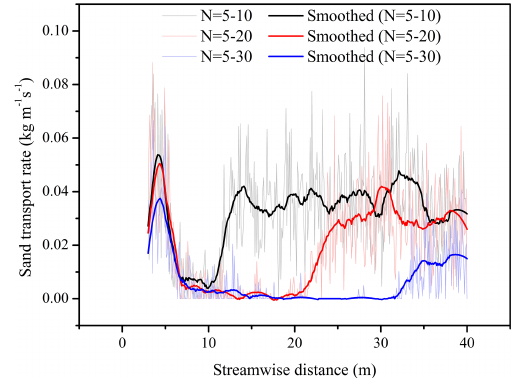
Figure 12. The streamwise sand transport rate in the different lay- ing length cases ( u τ = 0 . 6ms − 1 ; N = 5–10, 5–20, 5–30m). Dark lines are the result of